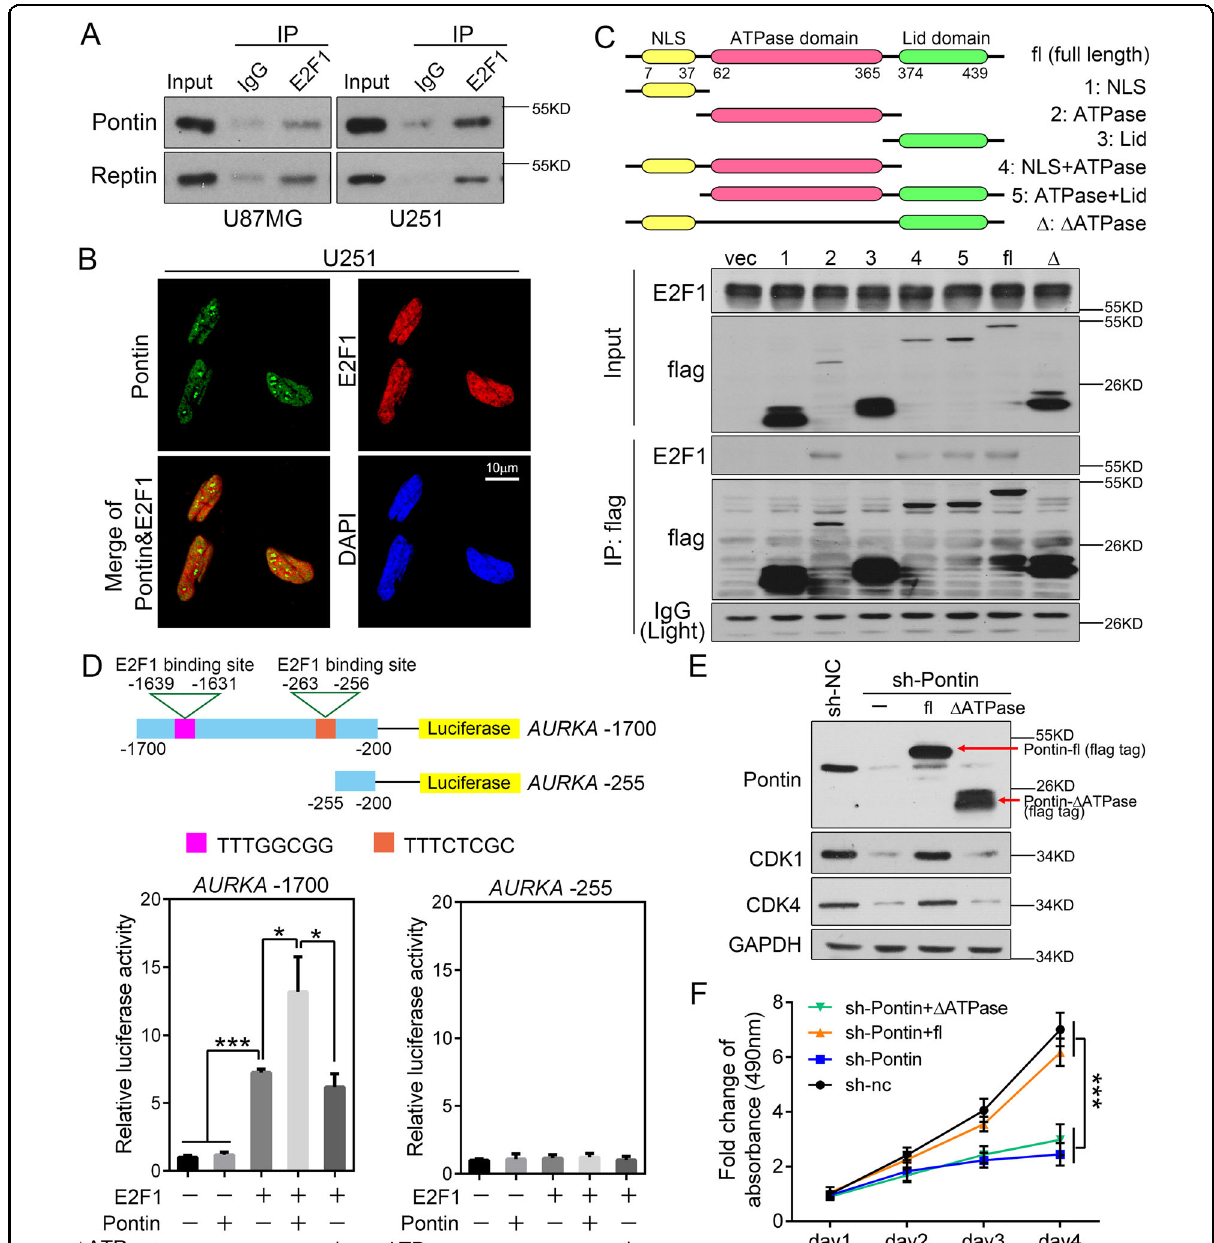
Fig. 5 Pontin functions as a transcription co-activator of E2F1 in GBM cells. A Co-IP using IgG or E2F1 antibody in U87MG and U251 cell extracts. Endogenous Pontin and Reptin were pulled-down and detected in the pulled-down fractions by immunoblot. B Co-localization of endogenous Pontin (green) and E2F1 (red) in U251 cells. Representative images from biological triplicate experiments are shown. Scale bar, 10 μ m. C Top: Schematic diagram of Pontin domains and construction of Pontin domain deleting mutants. All mutants are fl ag tagged. Bottom: Co-IP using the fl ag antibody in U87MG cell extracts. Interactions between fl ag tagged Pontin proteins and endogenous E2F1 were con fi rmed by immunoblot. D Luciferase assay was performed with reporters driven by AURKA promoter containing two E2F1-binding elements ( AURKA − 1700) or deleting E2F1- binding region ( AURKA – 255). Effect of Pontin or the Pontin Δ ATPase (the ATPase domain de fi cient mutant) expression on AURKA – 1700 or AURKA – 255 promoter-luciferase activity in the presence or absence of E2F1 was shown. Luciferase activities were normalized by β -galactosidase activity. Values are expressed as mean ± SD of three independent experiments. * P < 0.05; *** P < 0.001. E Western blot analyses of Pontin, CDK1, and CDK4 expressions in stable U87MG sub-cell lines (sh-NC, sh-Pontin) transfected with indicated plasmids. F The growth curves of the indicated cells assessed by MTS assays. Data are presented as the mean ± SD. *** P <